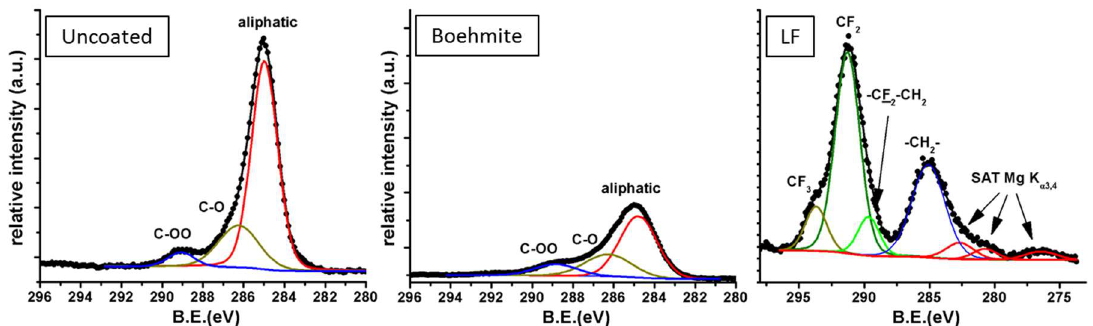
Figure 6. C1s portions of the X-ray photoelectron spectroscopy (XPS) spectra for uncoated ( left ), boehmite-coated ( middle ) and LF-coated aluminum ( right ).